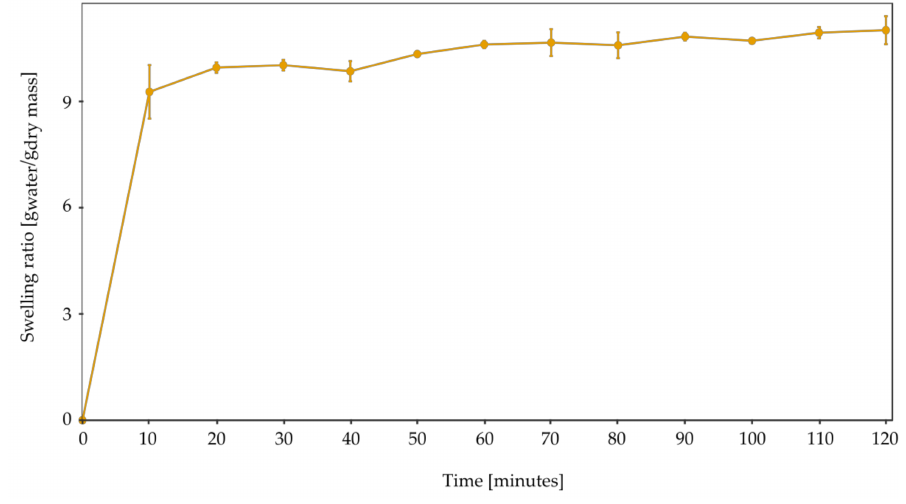
Figure A1. Swelling ratio of κ -Car 0.2 (The data are presented as the means ± SD from at least three independent